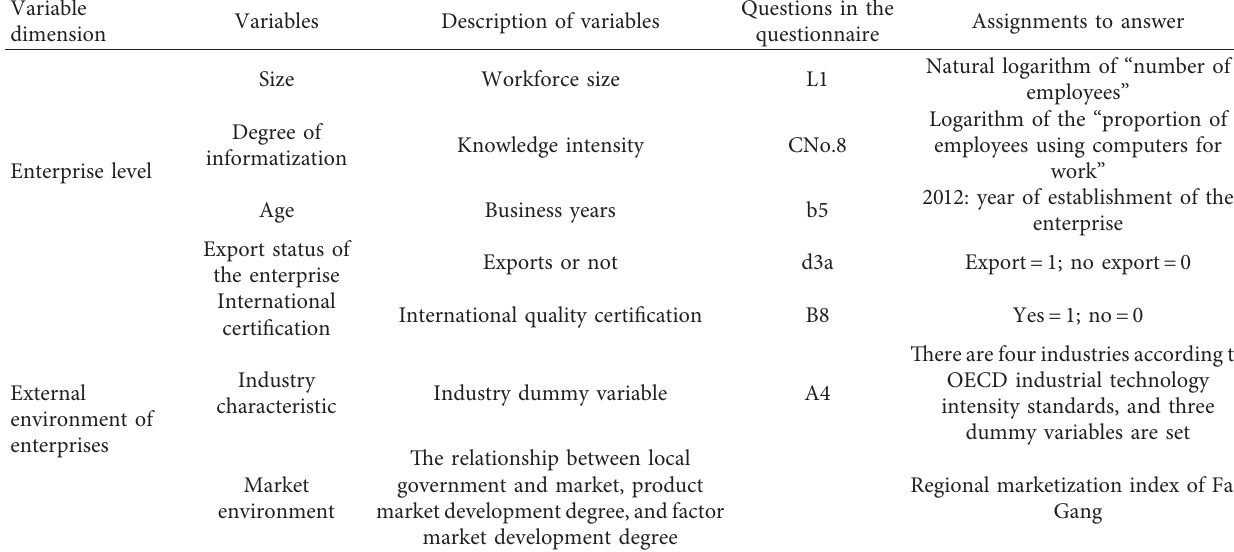
Table 4: Control